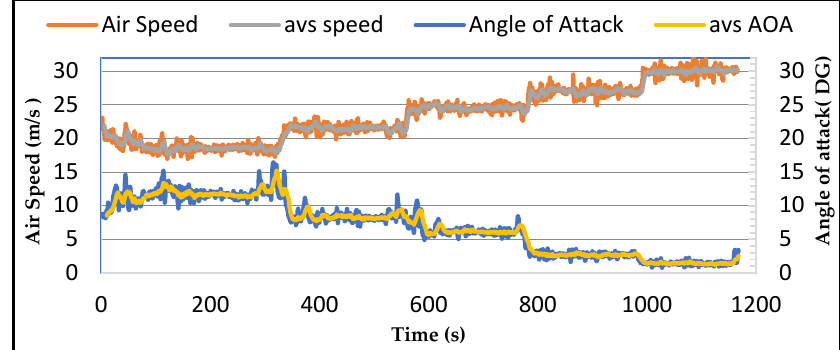
Figure 7. Relation of airspeed and AOA in actual